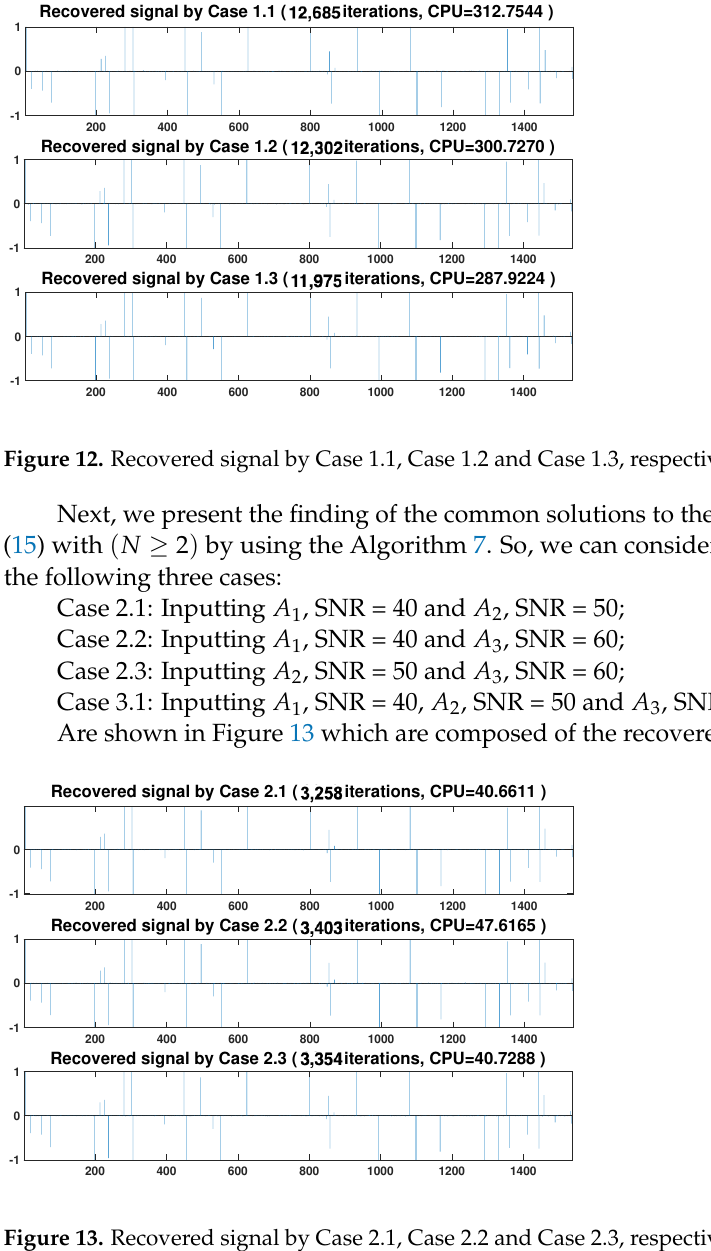
Figure 13. Recovered signal by Case 2.1, Case 2.2 and Case 2.3,